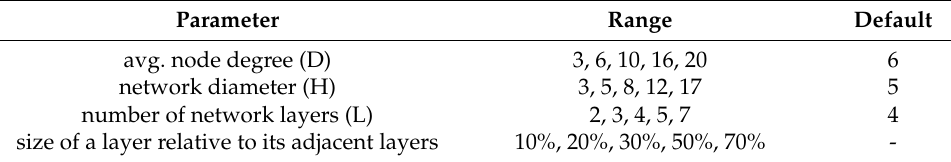
Table 2. Experimentation parameters values. Parameter Range Default avg. node degree (D) 3, 6, 10, 16, 20 6 network diameter (H) 3, 5, 8, 12, 17 5 number of network layers (L) 2, 3, 4, 5,